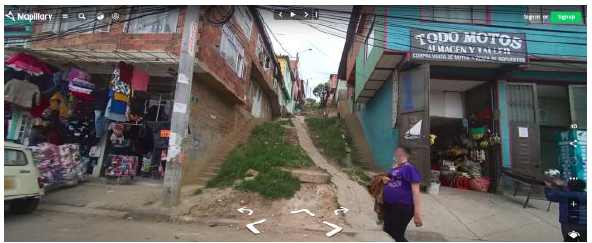
Figure 2 . Mapillary